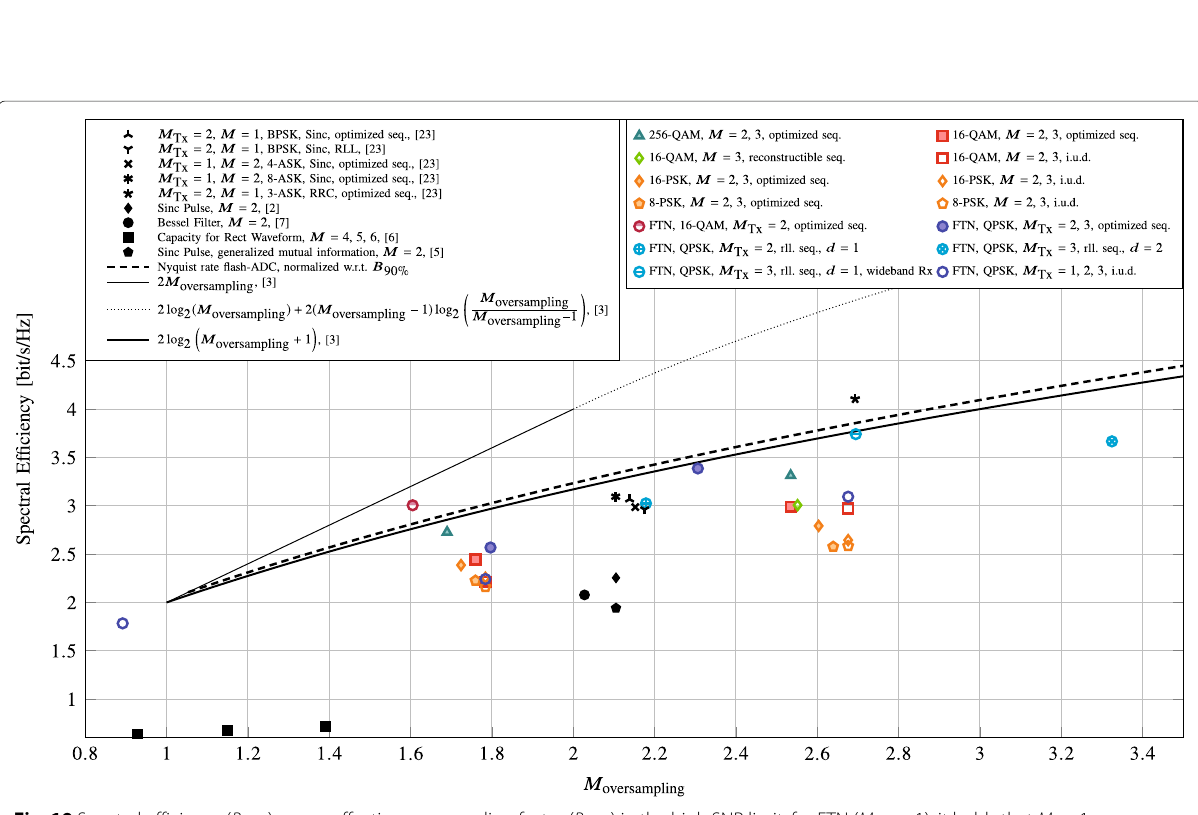
Fig. 19 Spectral efficiency ( B 95% ) versus effective oversampling factor ( B 95% ) in the high SNR limit; for FTN ( M Tx > 1), it holds that M =